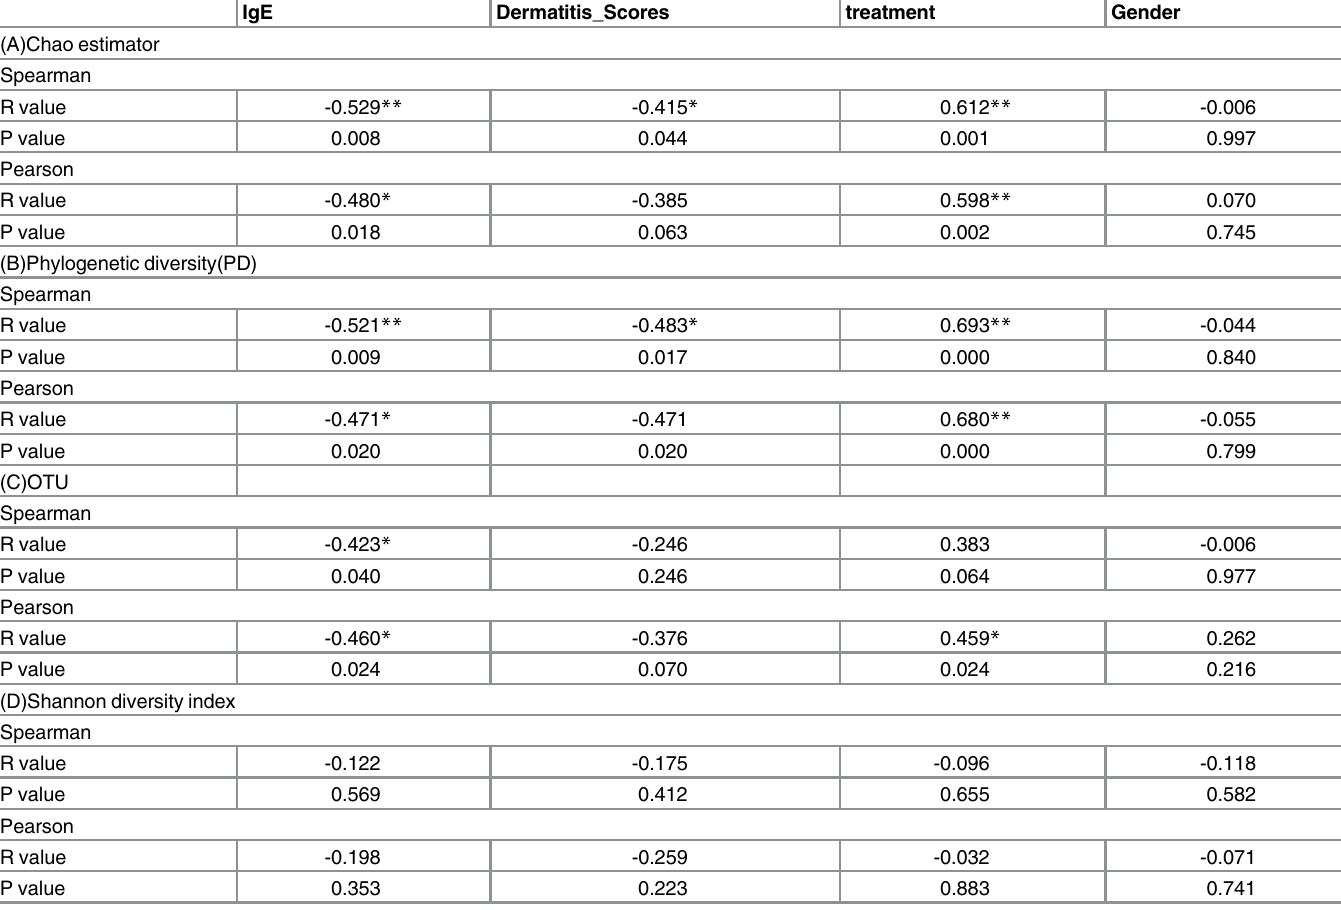
Table 1. Correlation between microbial richness/diversity and dermatitis severity indices and other